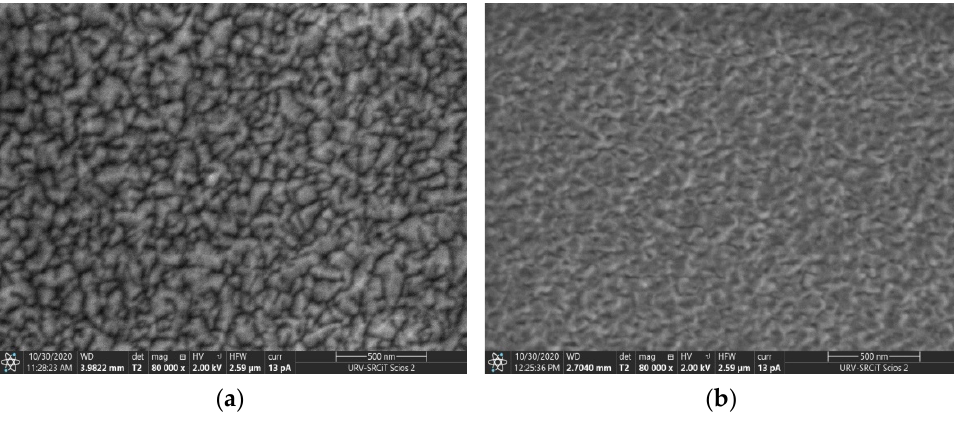
Figure 2. FESEM images of pure ZnO ( a ), and Dy@ZnO sample ( b ).